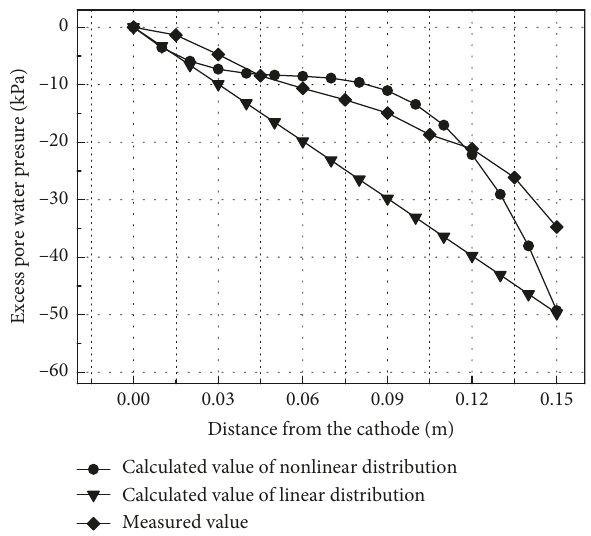
Figure 8: Distribution of excess pore water pressure in three different situations ( t �